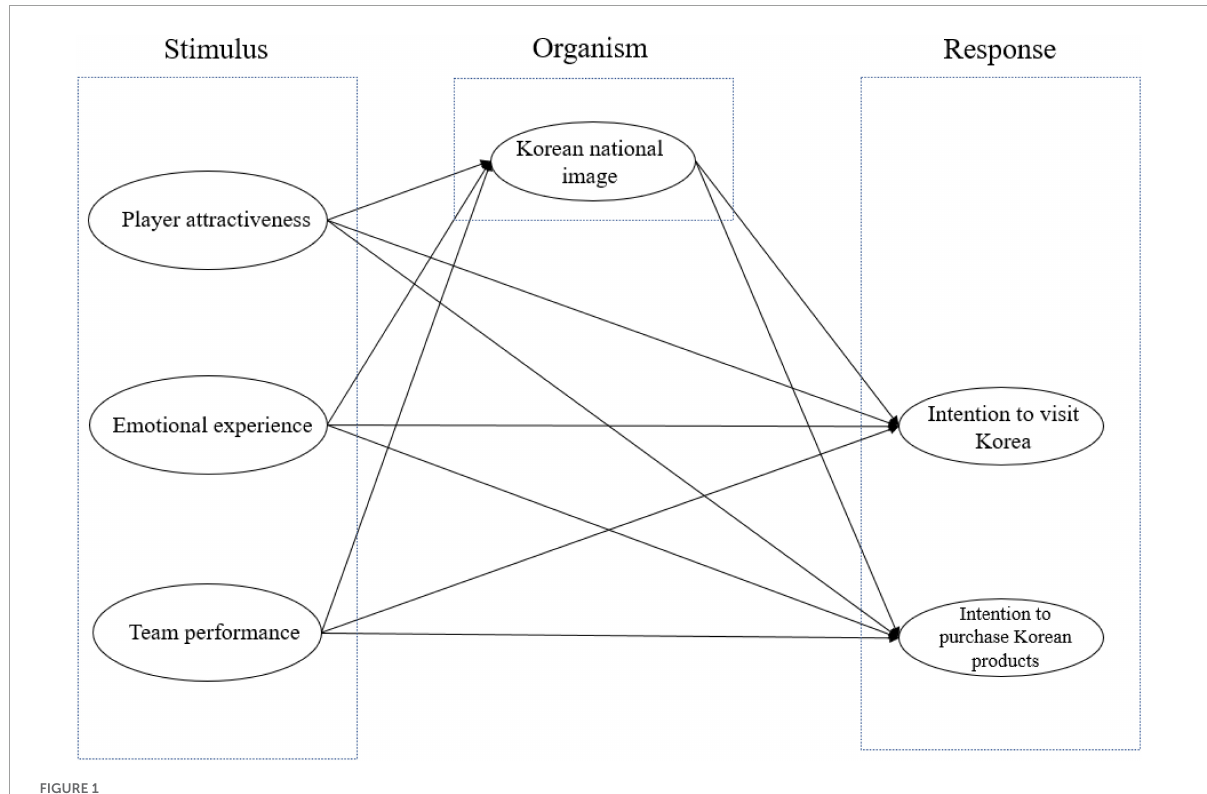
FIGURE1 Research